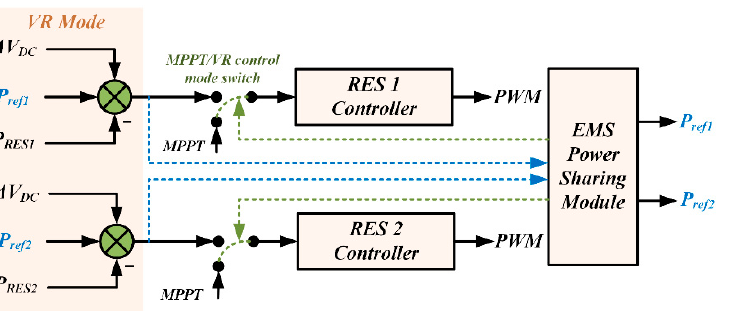
Figure 4. Multiple renewable energy sources (RES) units power sharing control in the EMS VR mode.